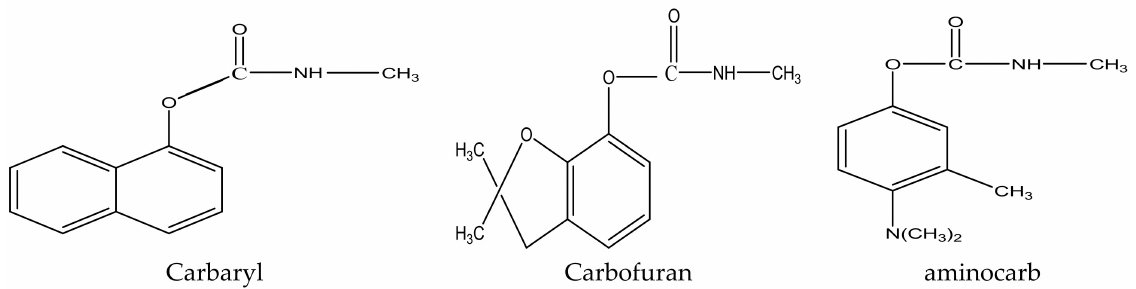
Figure 1. Structures of commonly used carbamate pesticides.